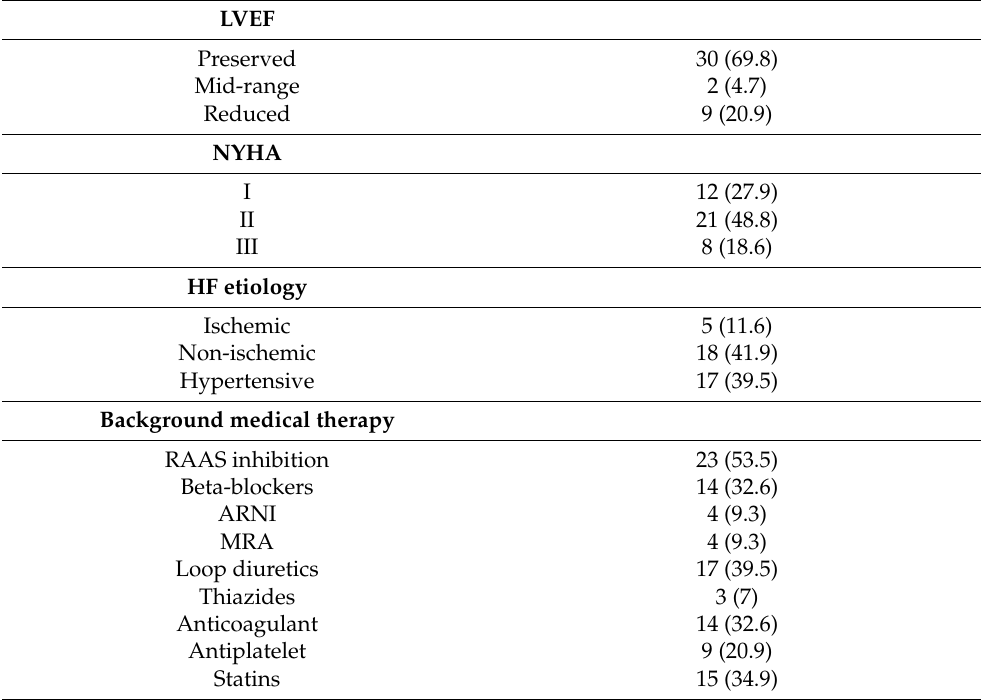
Table 5. Clinical characteristics of CHF patients.